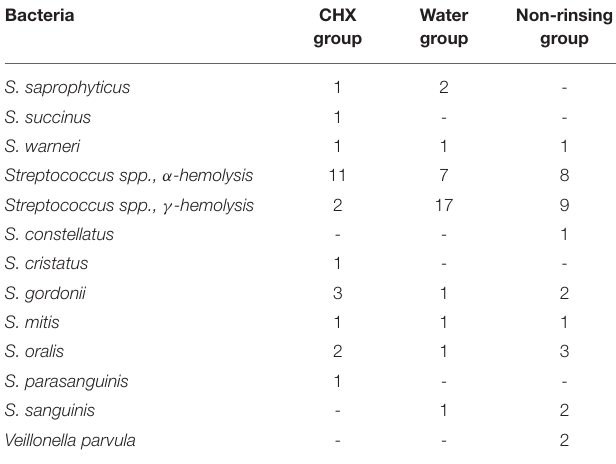
TABLE 1 | Detection frequency of bacterial species for CHX rinsing, water rinsing and, non-rinsing (102 samples each). Bacteria CHX Actinomyces naeslundii - Advenella